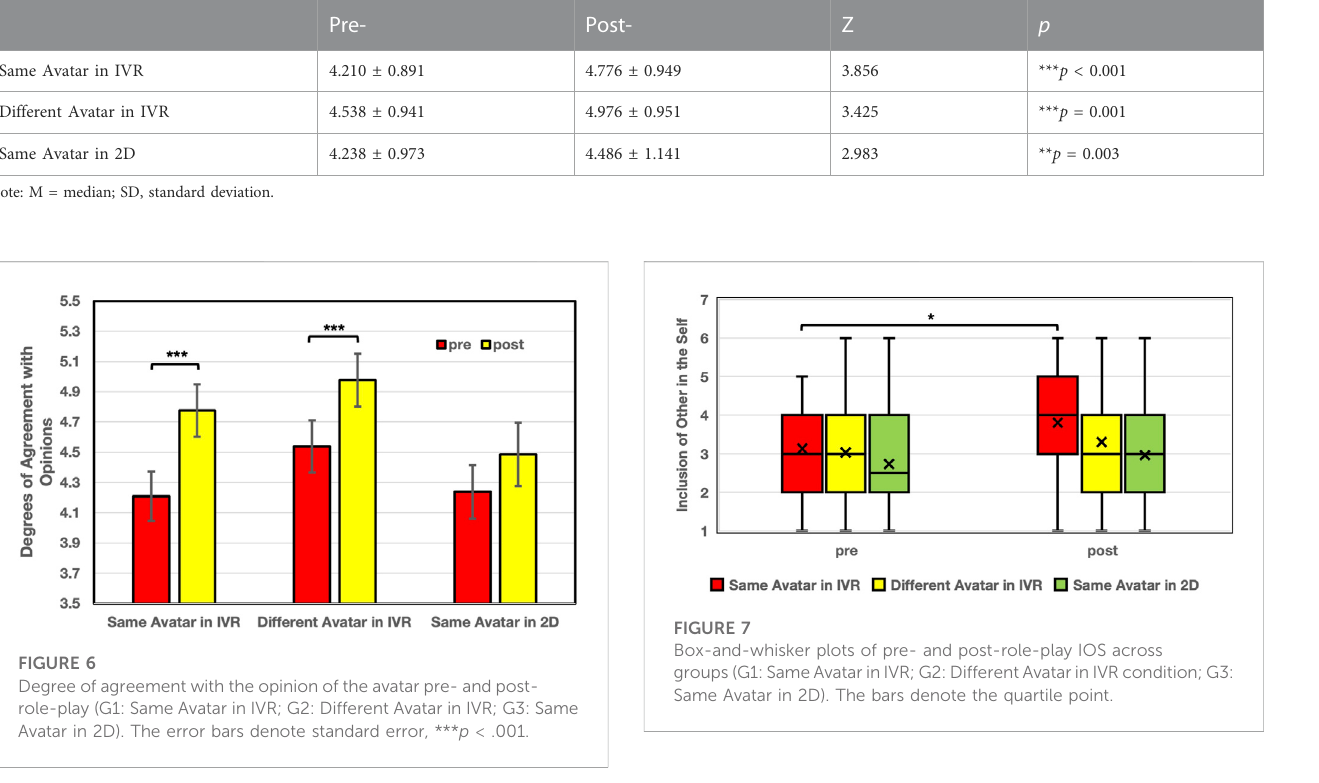
TABLE 3 Differences in pre- and post-qualities of the friend introduced in the video (G1: Same Avatar in IVR; G2: Different Avatar in IVR; G3: Same Avatar in 2D).